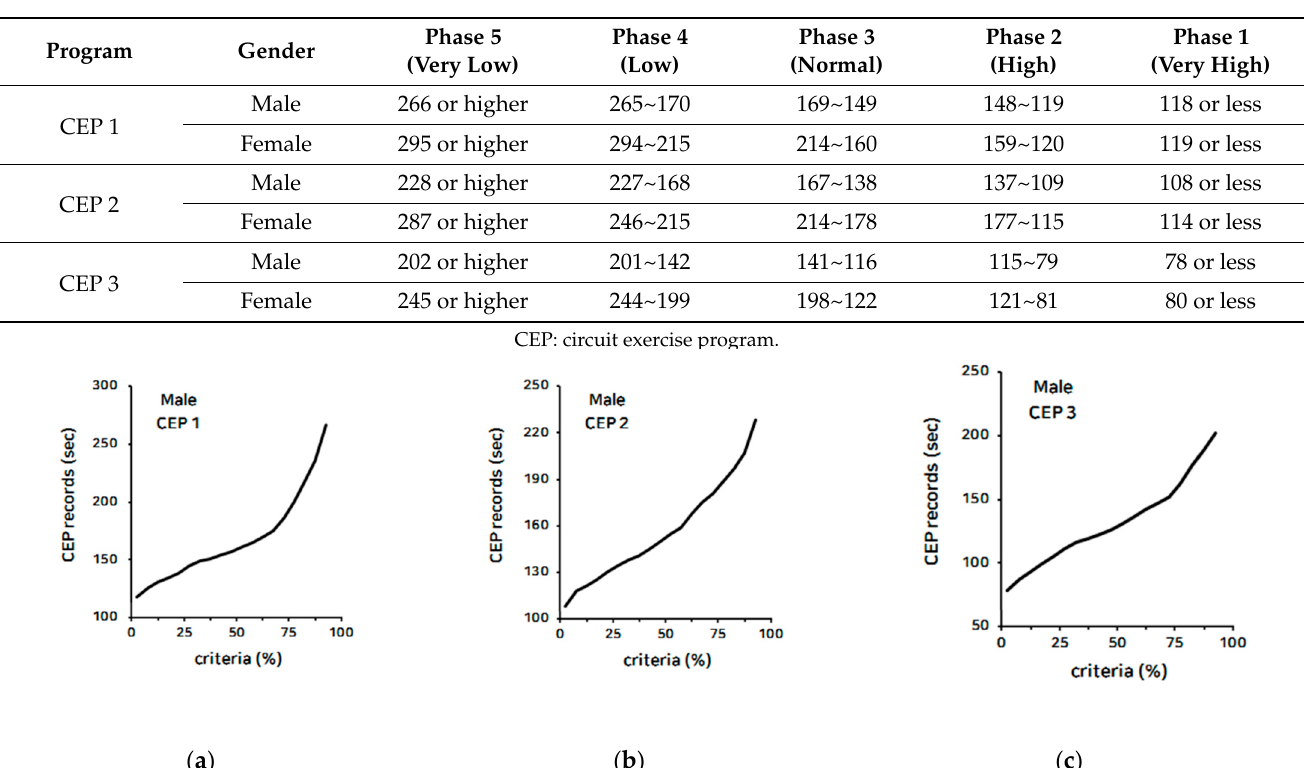
Table 6. Criteria of circuit exercise program (Unit: sec).